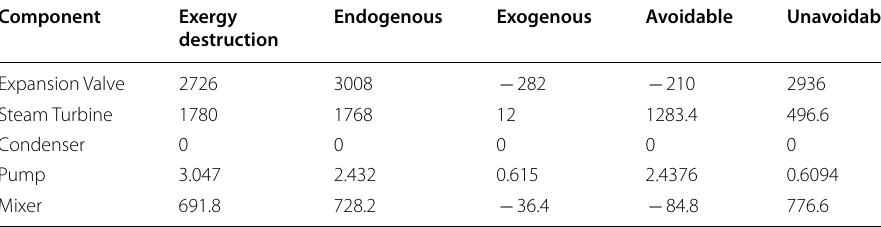
Table 6 Results of advanced exergy analysis of various system components